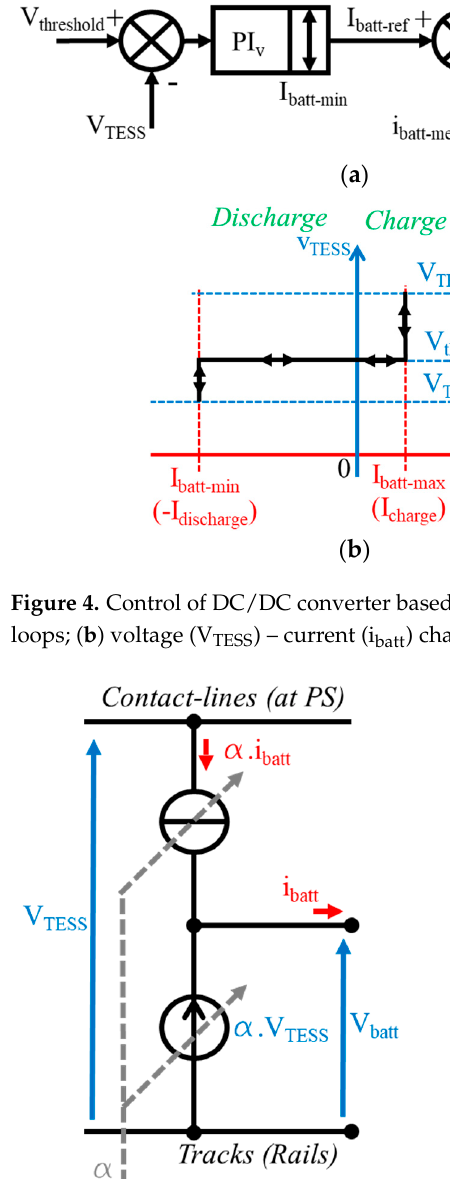
Figure 5. DC/DC converter averaged model.